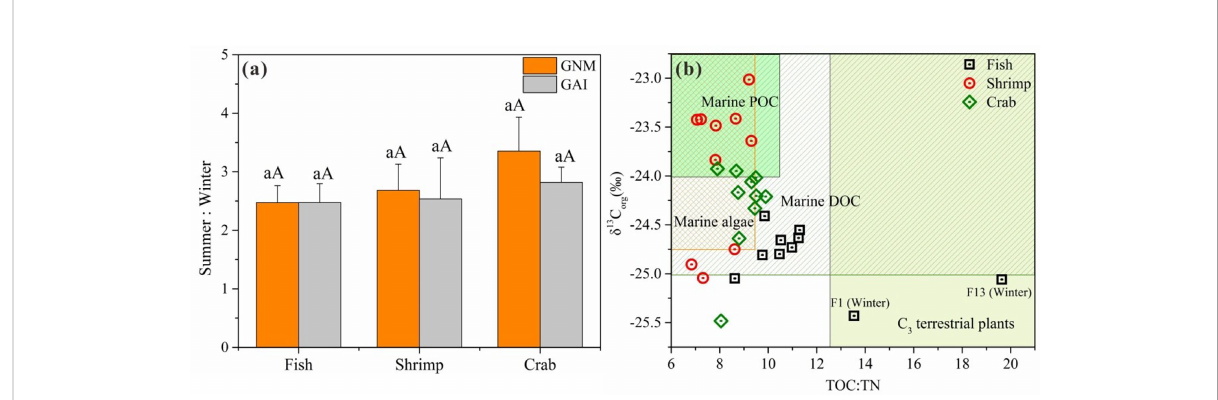
FIGURE 3 The temperature sensitivity of sediment GNM and GAI rates to seasonal change in those three ponds (A) ; Determination of organic matter sources from autochthonous or allochthonous (B) . The backgrond ranges of organic matter difference sources were obtained by Lamb et al. (2006). Statistically signi fi cant difference between seasons is labeled in the different uppercase letters, and the signi fi cant difference between aquaculture ponds is labeled in the different lowercase letters. The error bar represents the standard